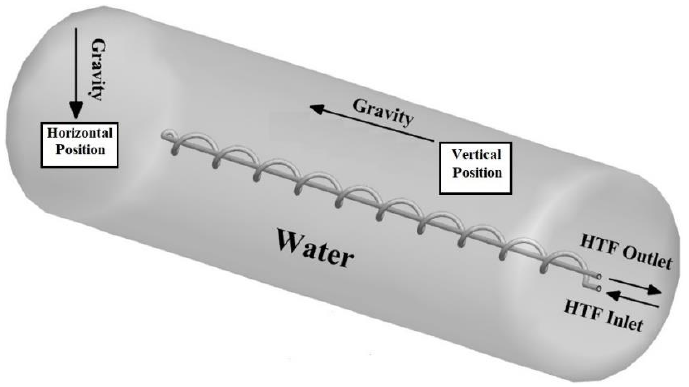
Figure 1. Schematic view of the computational domain presenting the two considered positions, horizontal and vertical.